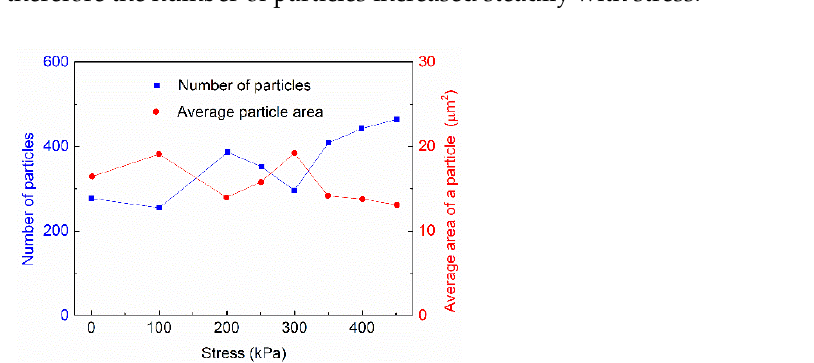
Figure 7. Directional particle distribution of structural elements under a stress of 400 kPa. 3.1.5. Mesoscopic Structure-Stress Evolution Model of the Soft Marine Soil Creep Process The purpose of this section is to quantify the relationship between mesoscopic pa- rameters and stress (Figure 8). The reason these groups of data were selected for fitting is that the data points have obvious regularity. There is a strong negative linear relationship between porosity and stress ( R 2 = 0.9800) as well as between pore ratio and stress ( R 2 = 0.9584). In addition, there is a nonlinear relationship between fractal dimension of the pore distribution and stress (fitted equation: D d = 8.335 × 10 − 7 σ 2 − 6.54 × 10 − 4 σ + 1.8803) as well as probability entropy of particle orientation and stress (fitted equation: H m = 8.03 × 10 − 7 σ 2 − 5.20 × 10 − 4 σ + 0.9603). The results show that the creep of soft marine soil is caused by directional redistribution of particles under stress, which includes crushing, moving and rotating of particles under stress. The porosity ratio and porosity represent the number of pores in the soil and reflect the consolidation of the soft marine soil structure. Directional probability entropy reflects the degree of ordering in the particle arrangement. The fractal